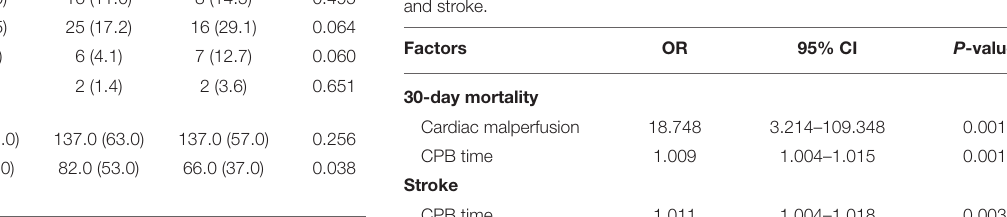
Figure 2B . On Cox regression analysis, age, diabetes, cardiac